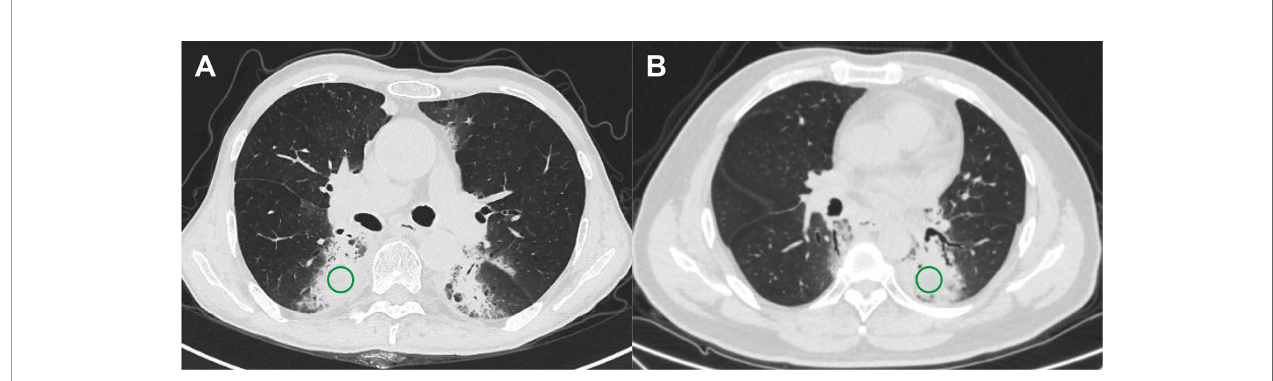
FIGURE 1 | Examples of regions of interest for two subtypes of pneumonitis. (A) Checkpoint inhibitor-related pneumonitis on routine CT and (B) radiation pneumonitis on routine